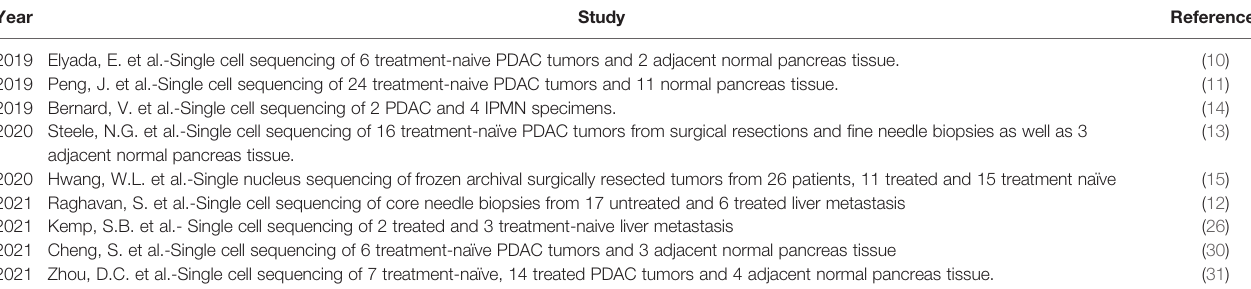
TABLE 2 | All signi fi cant published studies that have provided new single cell RNA sequencing datasets in pancreatic